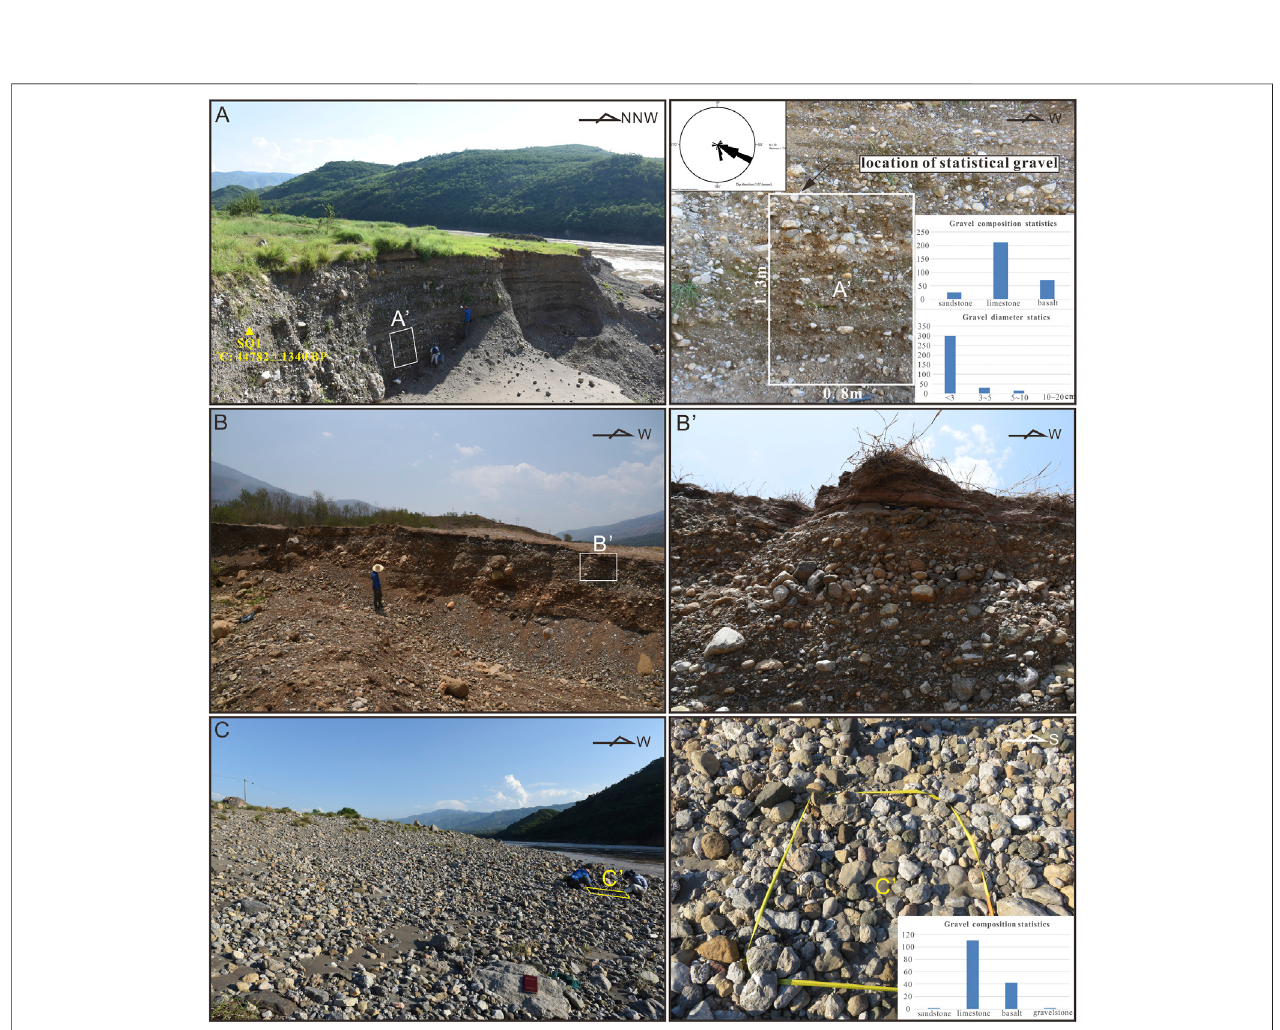
FIGURE6| Gravelstatisticallocations(seethelocationin Figure3 ). (A) and (B) PhotosnotethesidewallsandgravelsoftheQ 3 fannorthandsouthofLanyingpan, respectively; the white rectangle in (A) indicates the gravel statistical location, the rose diagram shows the paleo- fl ow direction, and the two histograms show the composition and size of gravels; (C) Photo of the gravel of the Jinsha River fl oodplain, with the gravel statistical location in the yellow rectangle.